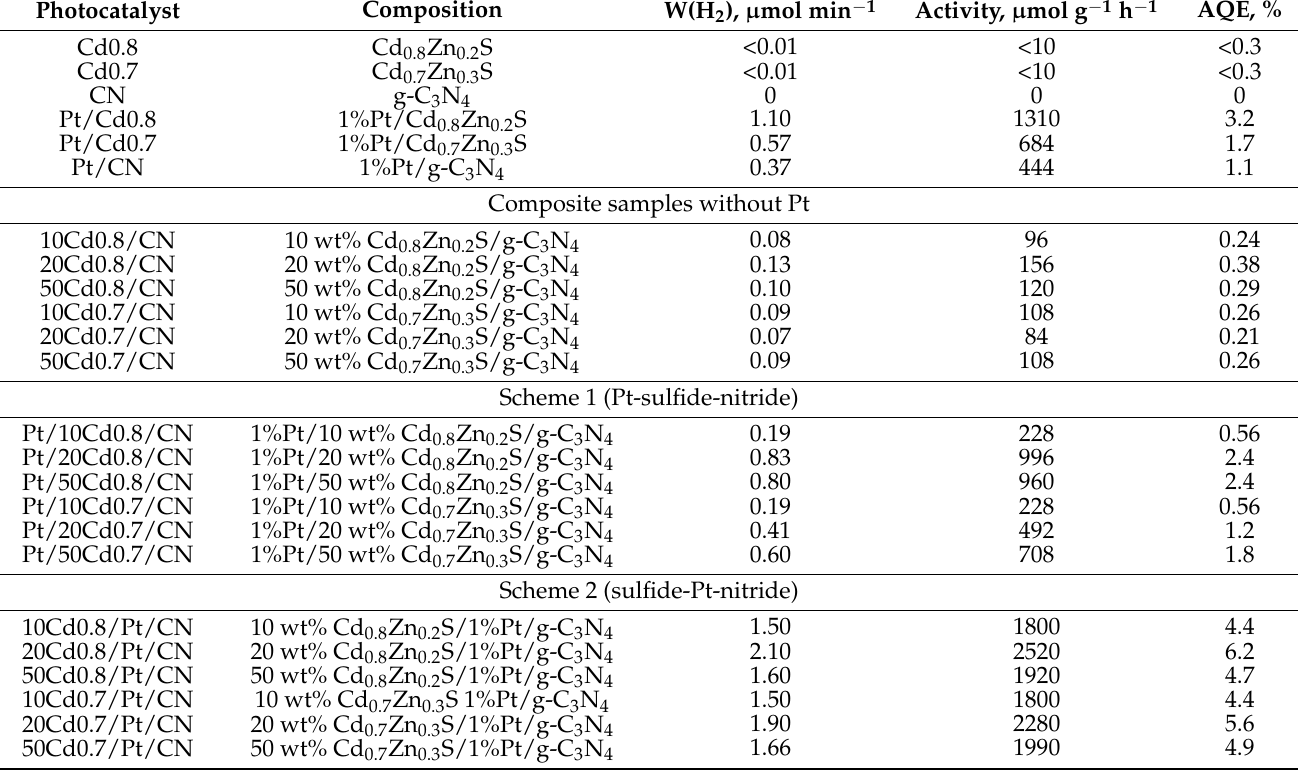
Abbreviations and activity of the synthesized photocatalysts in hydrogen